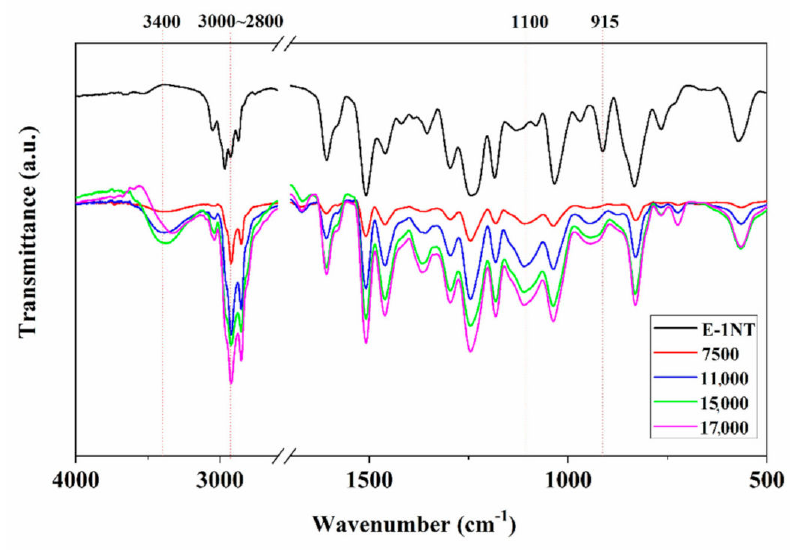
Figure 6. FTIR spectrogram of neat epoxy resin (E-1NT) and sizing emulsions with the four molecular weights.